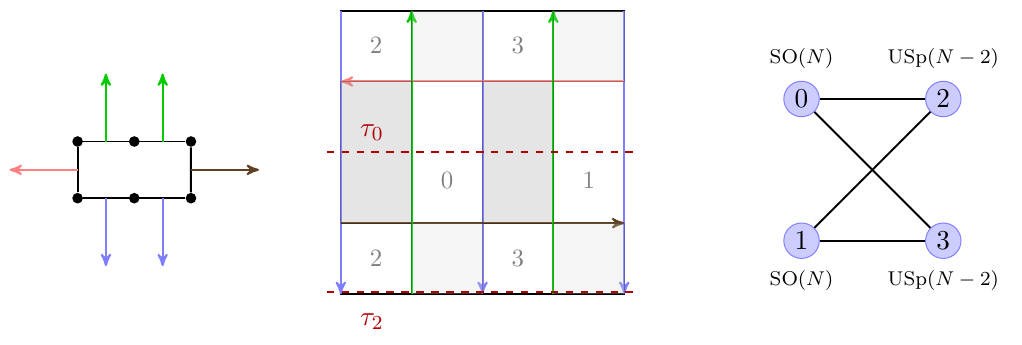
Figure 31. The model L 1 , 1 , 1 / Z 2 . On the left the toric diagram is drawn, at the center the five-brane and its orientifold with fixed lines, on the right the quiver resulting from the orientifold